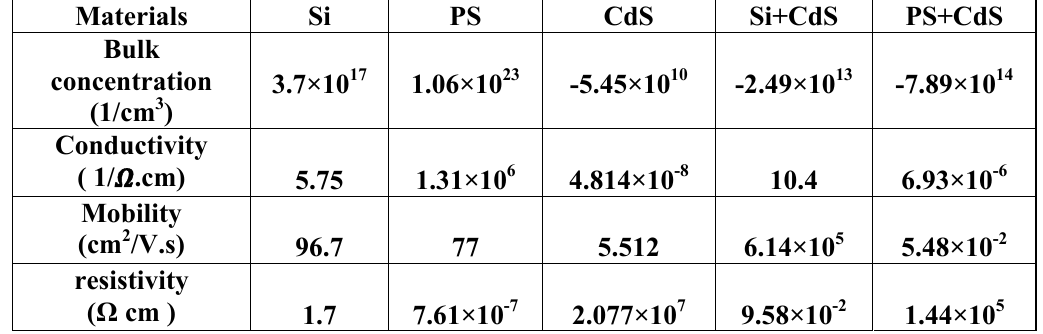
Table 1: Hall measurement for CdS